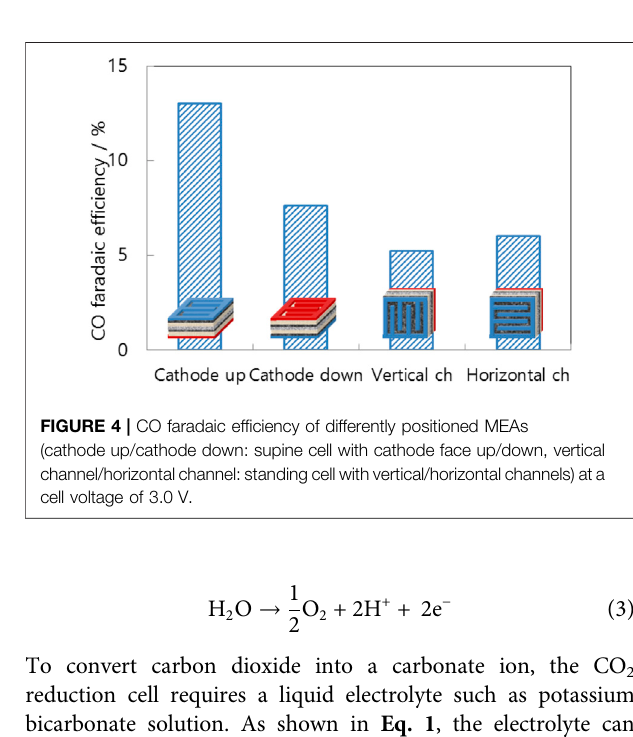
Frontiers in Energy Research |